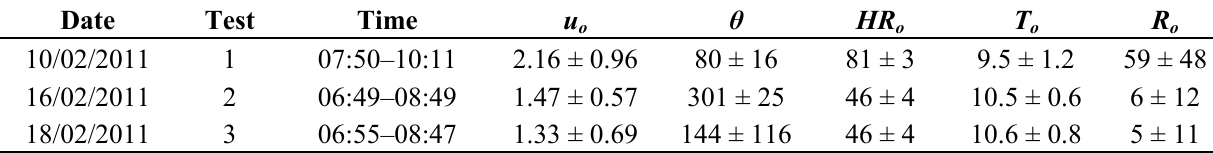
, wind speed [m∙s −1 ]. θ, wind direction [°]; RH o